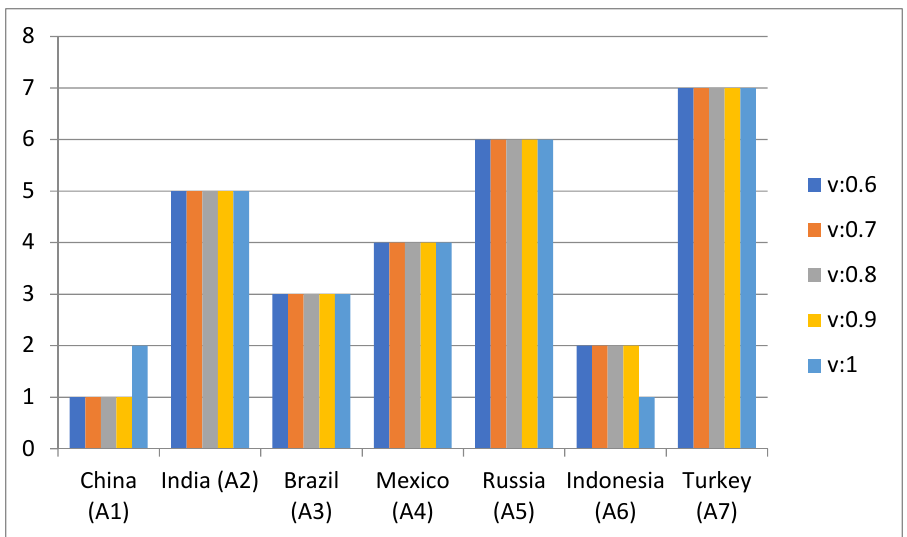
Figure 3. Ranking results for (v:0.6–1)